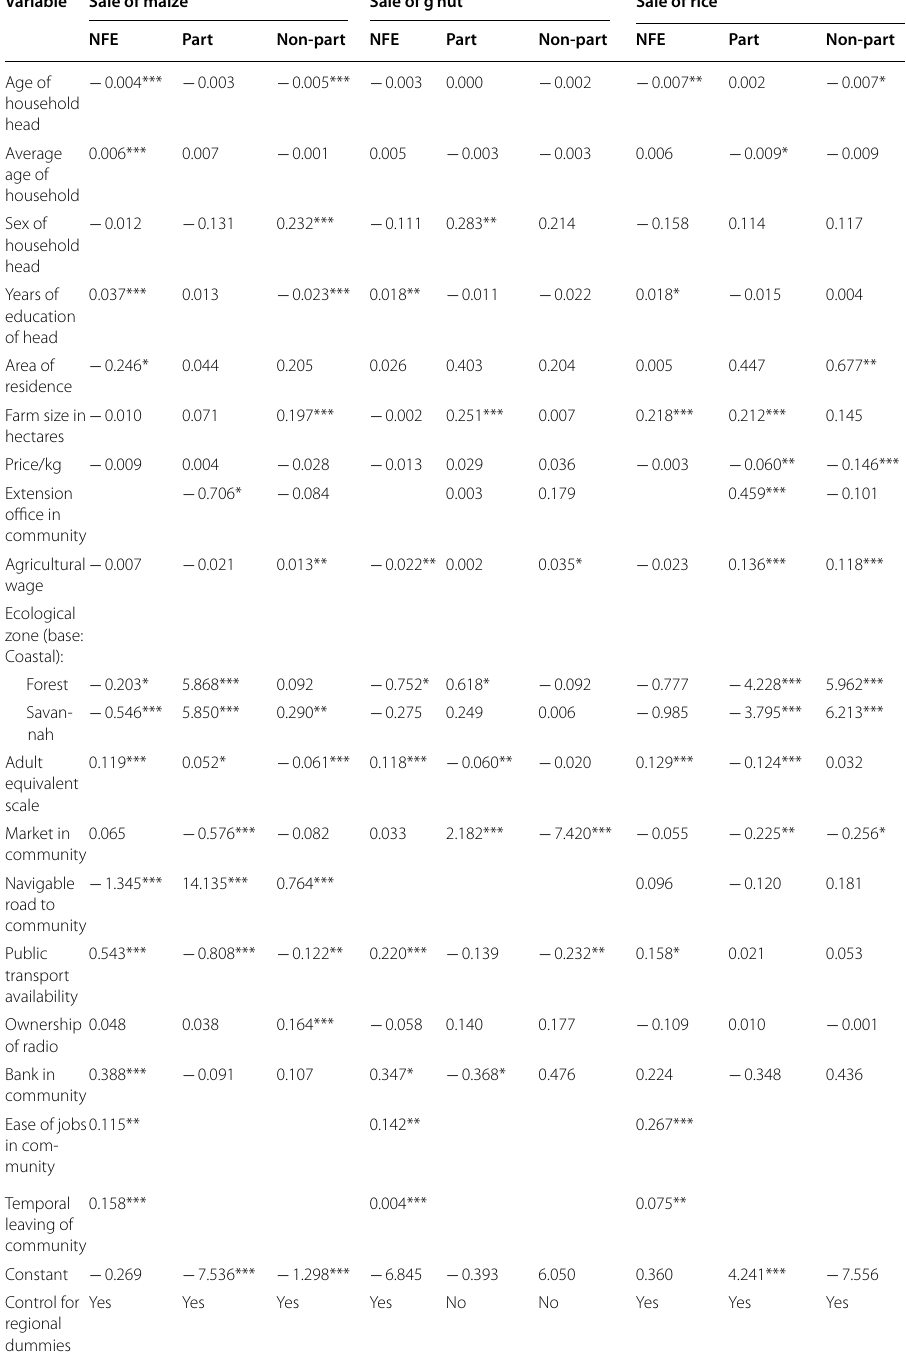
Table 5 Switch_probit estimates of determinants of nonfarm engagement and market participation for individual